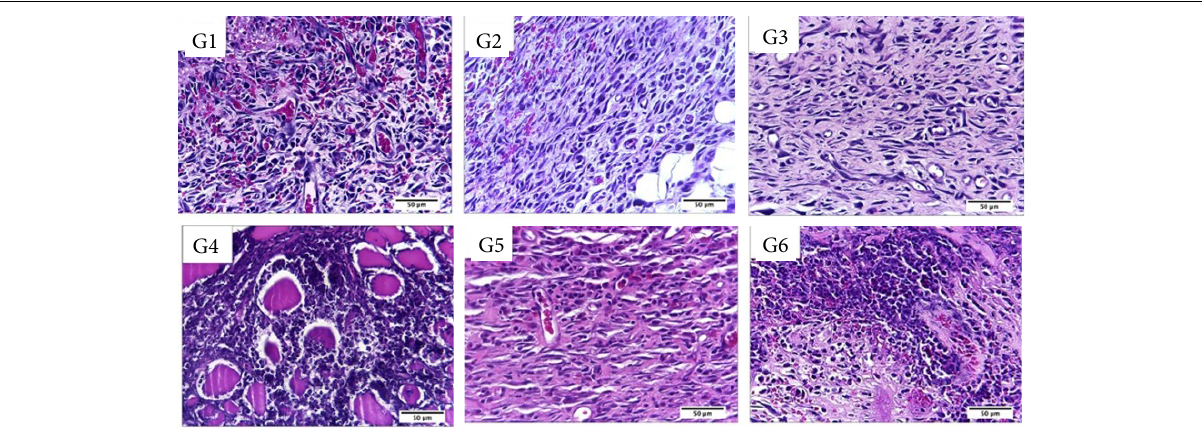
Figure 4 - Microscopic aspects of partial thickness burn wounds experimentally induced in Wistar rats and treated with silver-based dressings 7 DAI, scale bar = 200 μ m.